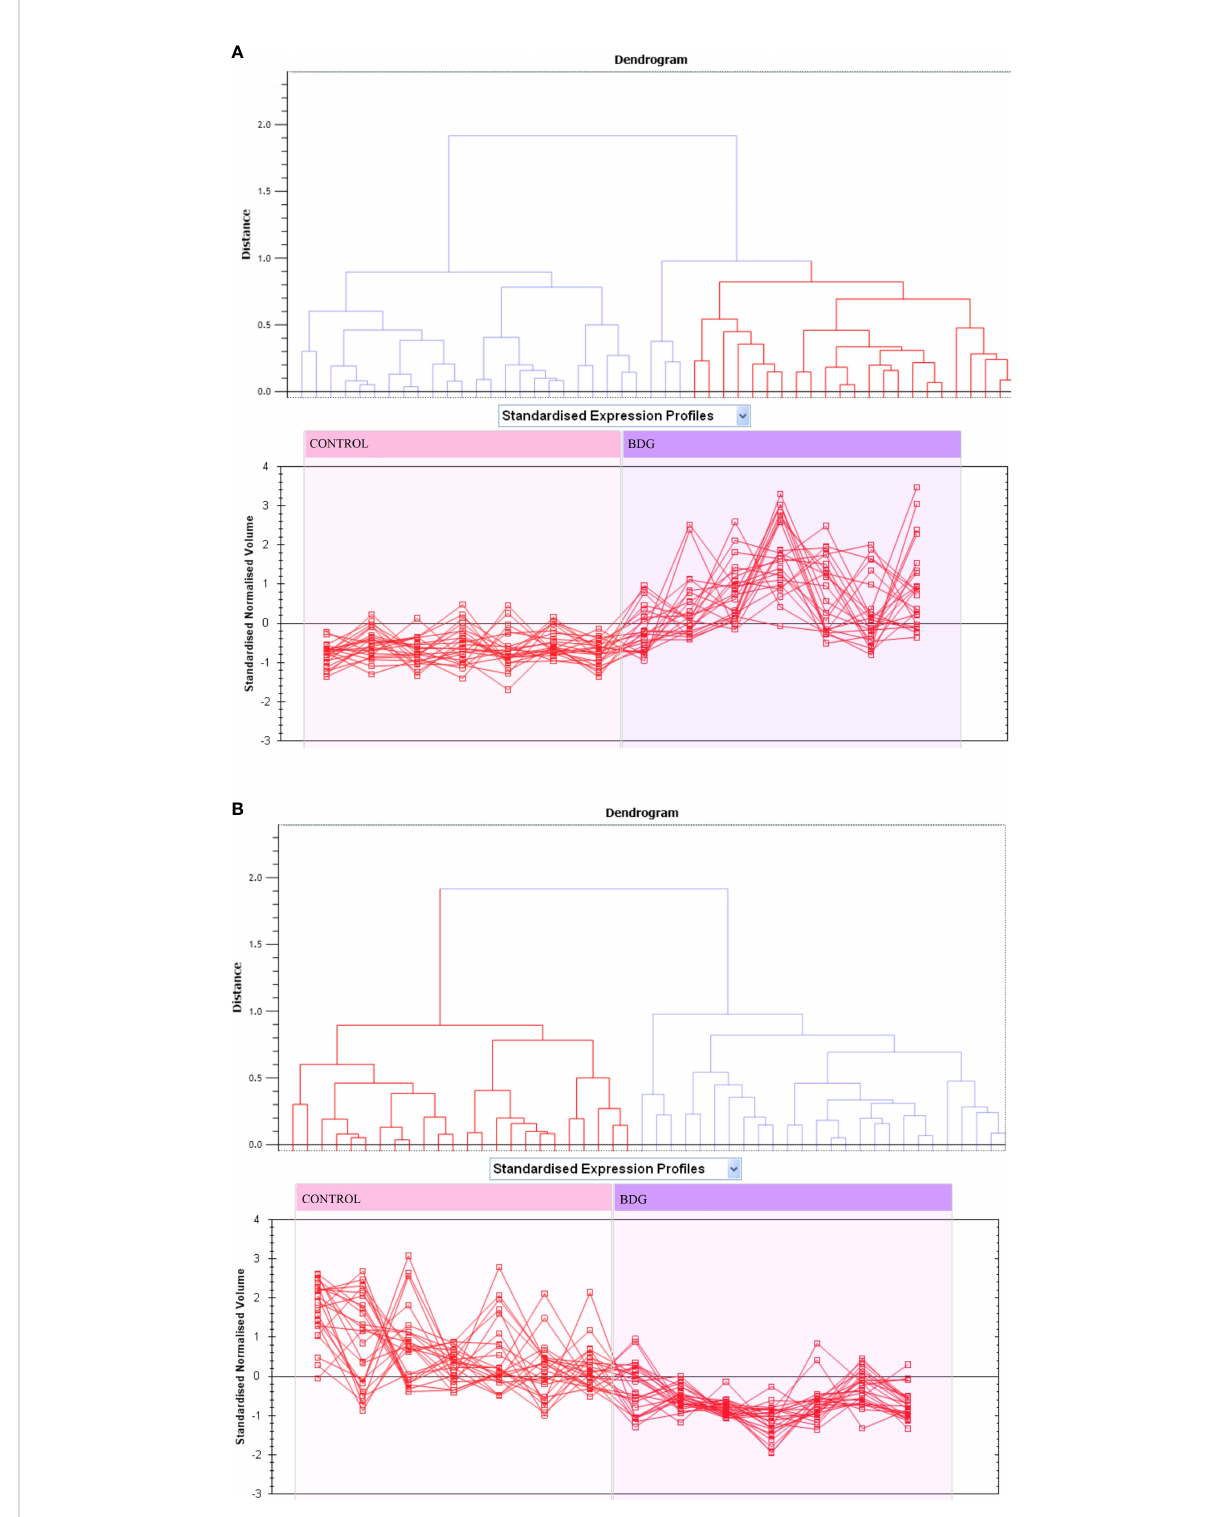
FIGURE 3 Expression pro fi les divided into expression pattern clusters, with the number of spots for each cluster indicated. Each line indicates a spot ’ s standardized abundance covering all gels and corresponds to one among the clusters created by hierarchical cluster analysis. The spots with increased abundance indicate the 46 proteins up regulated (A) . The spots with decreased abundance indicate the 44 proteins downregualted in thyroid tissue from patients with BDG compared to control states (B) (Progenesis